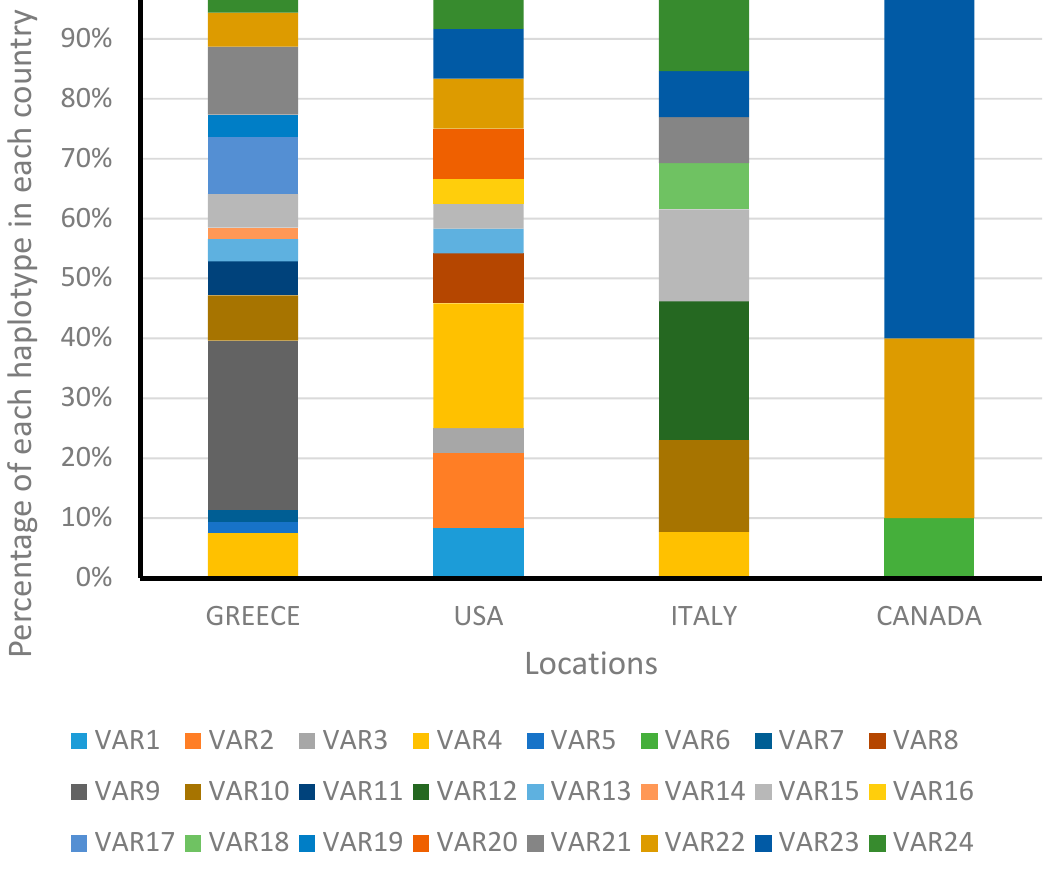
Figure 3. Summary of haplotype frequency of Halyomorpha halys adults based on Internal Transcribed Spacer 1 (ITS1) region.